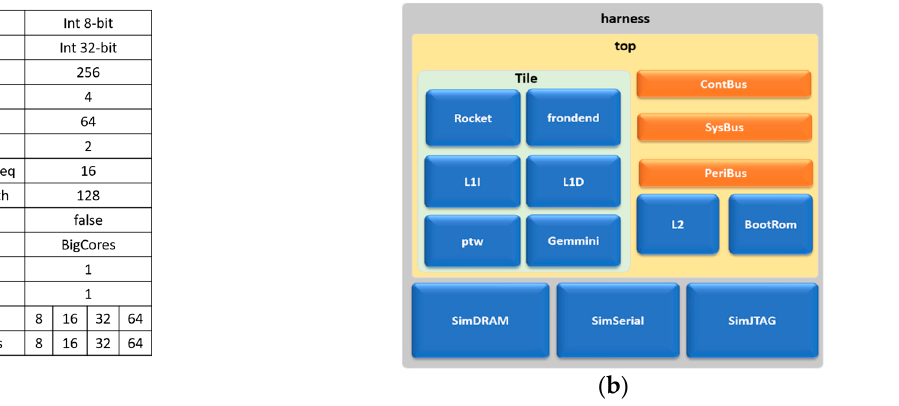
Figure 13. Gemmini SoC generation: ( a ) Gemmini configuration parameters; ( b ) Gemmini SoC gen- erated modules.